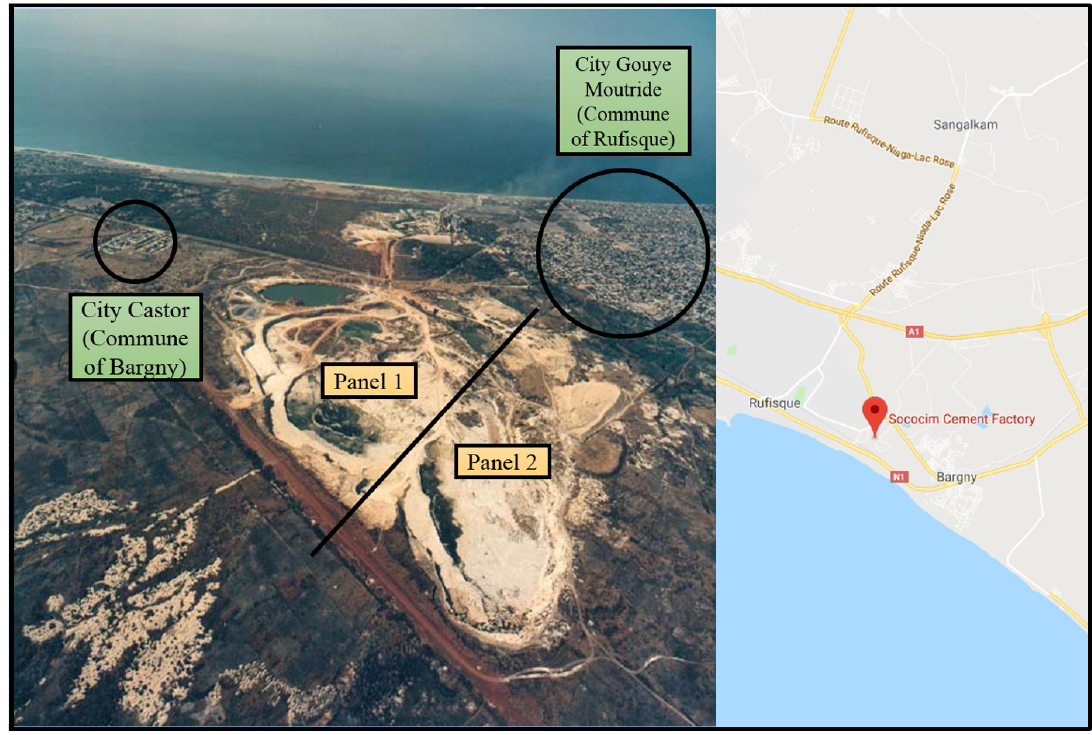
Figure 1: Location of the Bargny